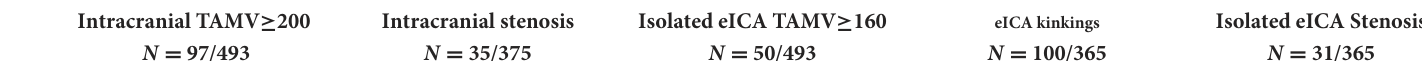
TABLE 3 Predictive risk factors for intra- and extracranial arteriopathies in patients with